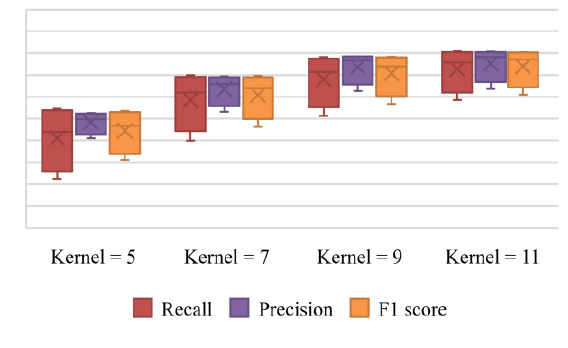
Figure 11. Performance of